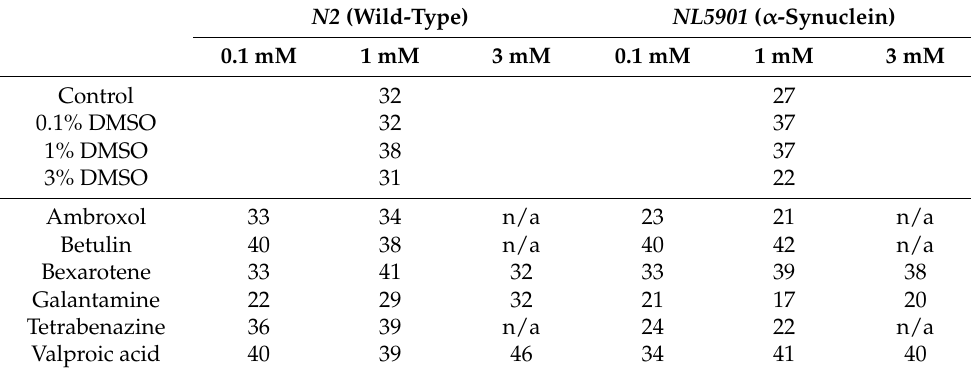
error of the mean (s.e.m.). The statistical tests are a one-way ANOVA where * p < 0.05, ** p < 0.01, *** p < 0.005, and **** p < 0.001. The blue bars show the control, FUdR, n = 62 over 6 independent replicates. All dark grey bars represent exposure to 0.1 mM for 1 week, light grey indicates 1 mM exposure, and white bars are for worms exposed to 3 mM of the drug. ( a ) Exposure to Ambroxol ( n = 20, 20, 12). Using ANOVA, there was no significant difference between the aggregate number of Ambroxol-exposed worms compared to the control. However, a 2-tailed 2-sample t -test gave a p = 0.029 between FUdR and 3 mM Ambroxol-exposed worms; ( b ) Betulin ( n = 33, 36). Note that 3 mM was not tested, as this was found to be toxic to C. elegans by other groups; ( c ) Bexarotene ( n = 20, 22, 21, 15); ( d ) Galantamine ( n = 13, 7, 11); ( e ) Tetrabenazine ( n = 22, 22, 15) showed no significant difference between the FUdR control and Valproic Acid-exposed worms nor did a t -test; ( f ) Valproic Acid ( n = 23, 22, 22). Table 1. Survey of the effect of drugs on body bending. Worms (strain N2 and NL5901 ) were exposed to each drug for 1 week (L4 + 7 days) after which they were assessed for body bending. All drugs were tested at 0.1, 1, and 3 mM, with the exception of Ambroxol, Betulin, and Tetrabenazine, which were not tested at 3 mM (shown by an “n/a”), as the worms paralyzed immediately upon being placed in the M9 buffer. For graphical representation, see Supplemental Figure S2. All experiments were repeated once, with a minimum of 11 worms per condition. The controls (FUdR and DMSO) were run with each experiment but are combined in the table. N2 (Wild-Type) NL5901 ( α